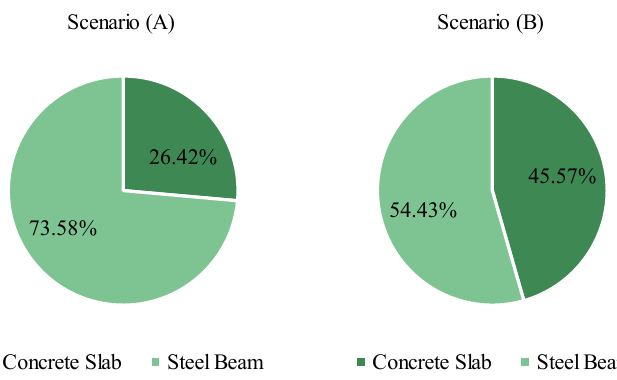
Figure 9. Contribution in emissions of each structural element.